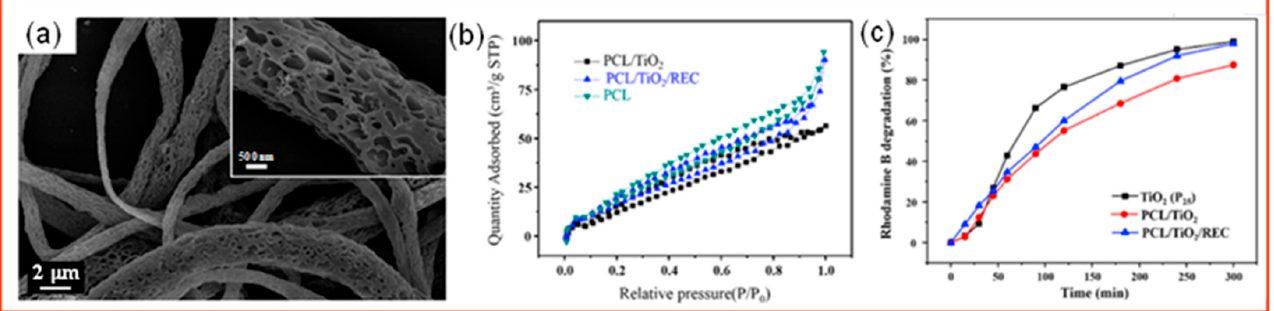
Figure 7. ( a ) SEM images of PCL/TiO 2 /REC fibers; ( b ) N 2 adsorption − desorption isotherms of each sample; ( c ) degradation rate of each sample to rhodamine B [137].